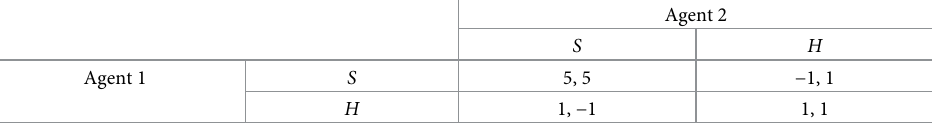
Table 1. Payoff matrix underlying the utility functions of the 2-player stag hunt game with two actions—Hare (H) and stag (S). Specifically, agent 1’s choices are cast in rows and agent 2’s choices are cast in columns. The utility given to agent 1 and agent 2 are the first and second numbers, respectively, of a given